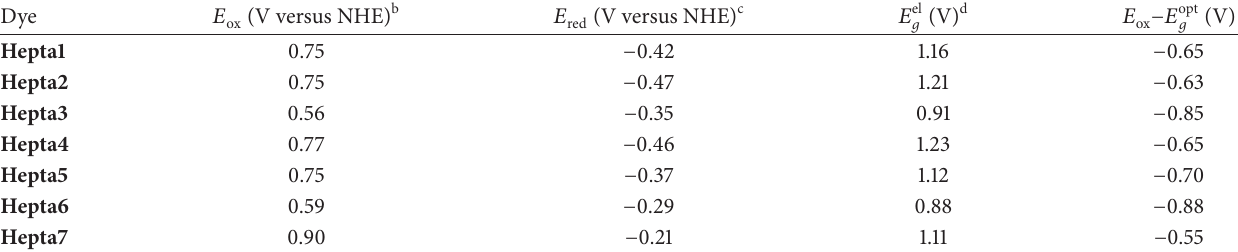
Table 2: Electrochemical properties of the unsymmetrical heptamethine dyes in dilute DMF solution a